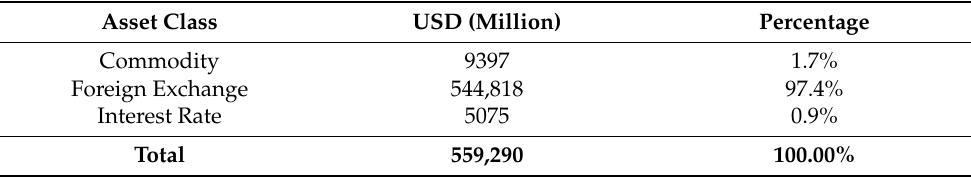
Table 1. one-year turnover of Indonesian OTC derivatives market in 2019. Table 1. One-year turnover of Indonesian OTC derivatives market in 2019.